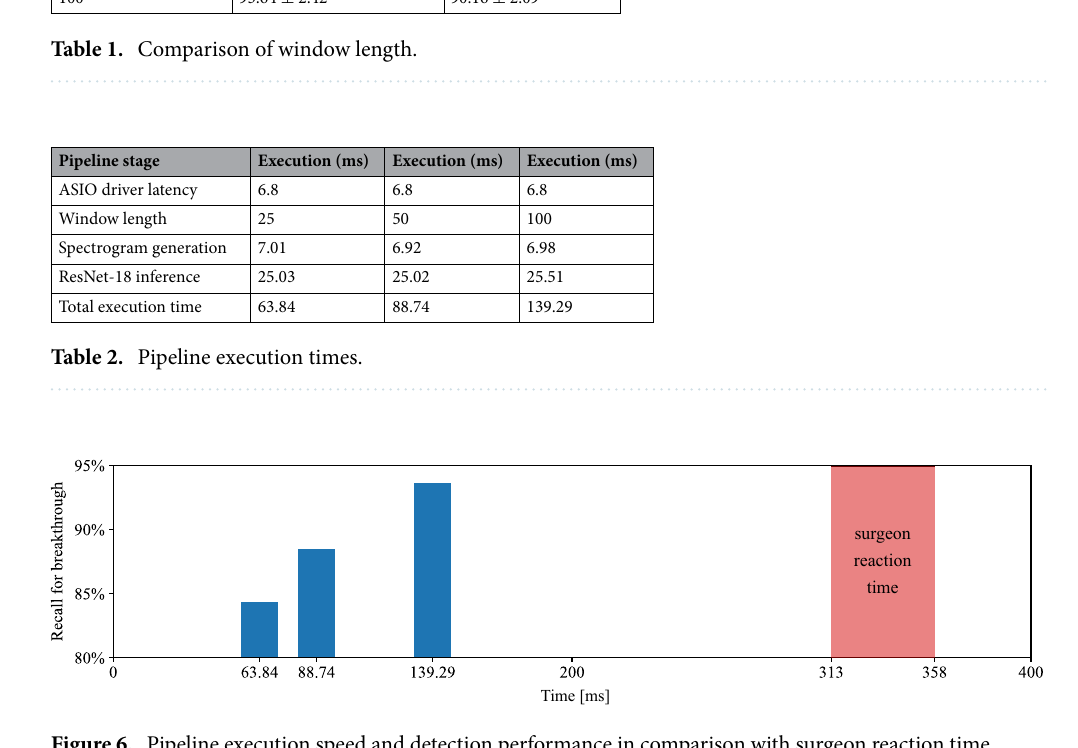
Figure 6. Pipeline execution speed and detection performance in comparison with surgeon reaction time, which has been measured to be in the range of 313 to 358 ms and degrading with advancing age 22 . The execution times 63.84 ms , 88.74 ms and 139.29 ms correspond to window lengths of 25 ms , 50 ms and 100 ms , respectively, as explained in the section “Comparison of window